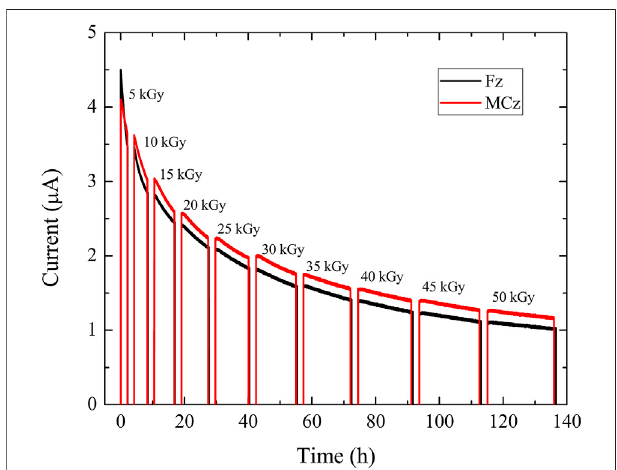
FIGURE 2 | Current signals delivered by pristine MCz and Fz diodes irradiated to doses from 5 kGy up to 50 kGy under dose rates of 2.44 kGy/h (MCz) and 2.36 kGy/h (Fz). Instrumental uncertainties of the current measurements are smaller than the size of the